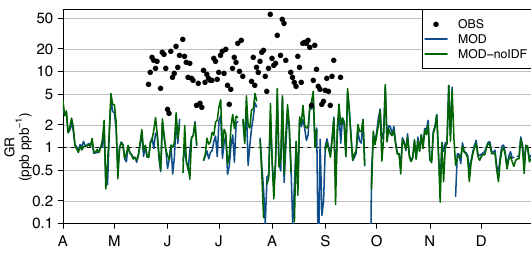
Figure 11. Observed and modeled daily